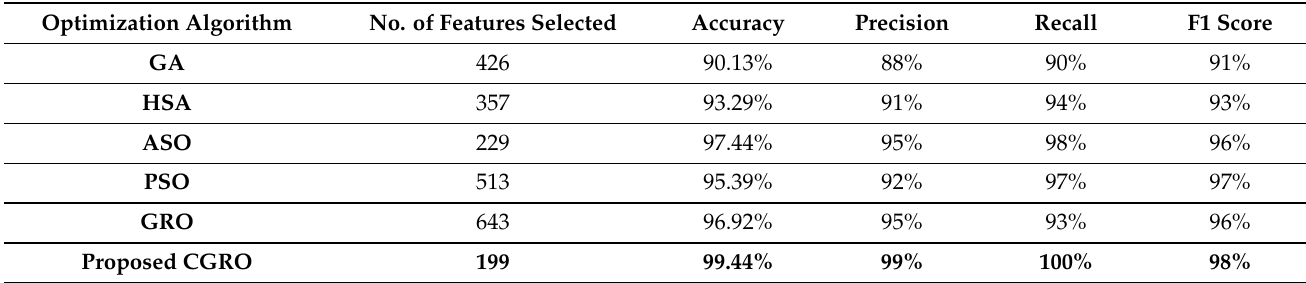
Table 8. Comparative study of different optimization algorithms with proposed CGRO based FS algorithm on Chest X-Ray 2 class dataset. The performance of proposed algorithm has been highlighted in bold text format. Optimization Algorithm